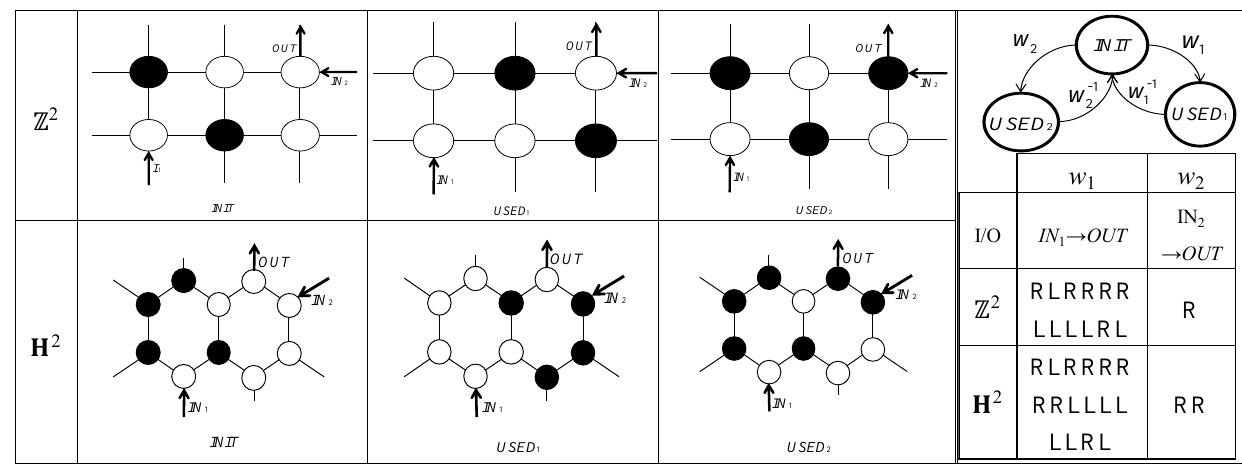
Figure 8. CONJunction